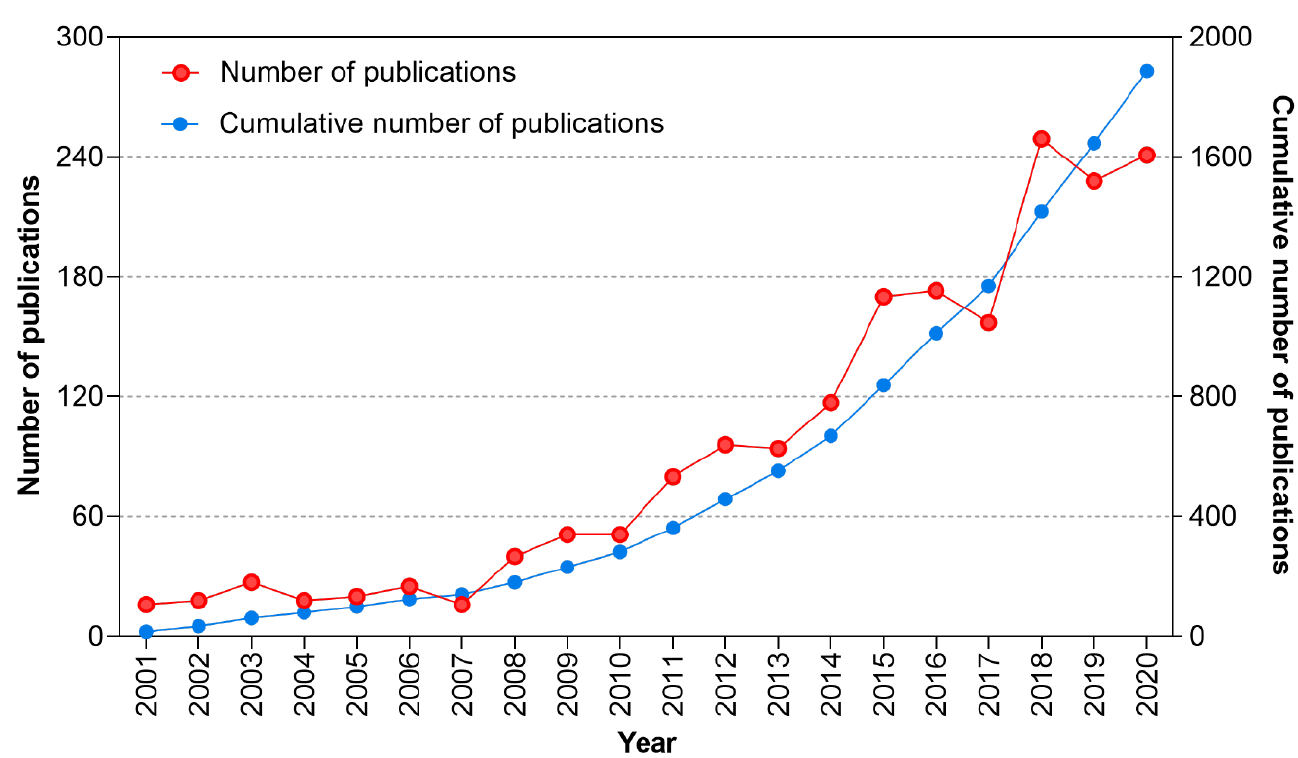
Figure 2. Annual number of publications and cumulative number of publications by year.